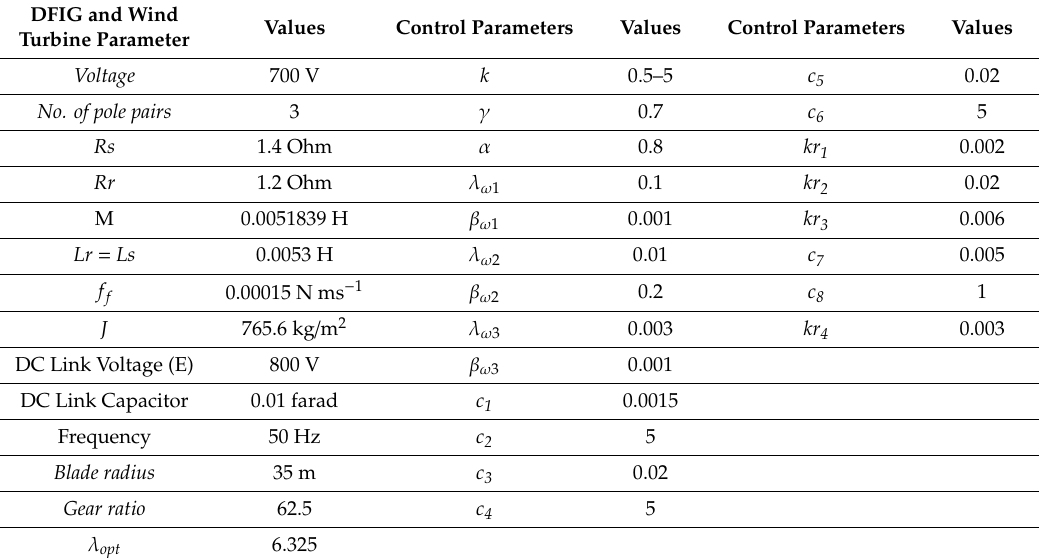
Table A1. System and controller parameters. DFIG, doubly fed induction